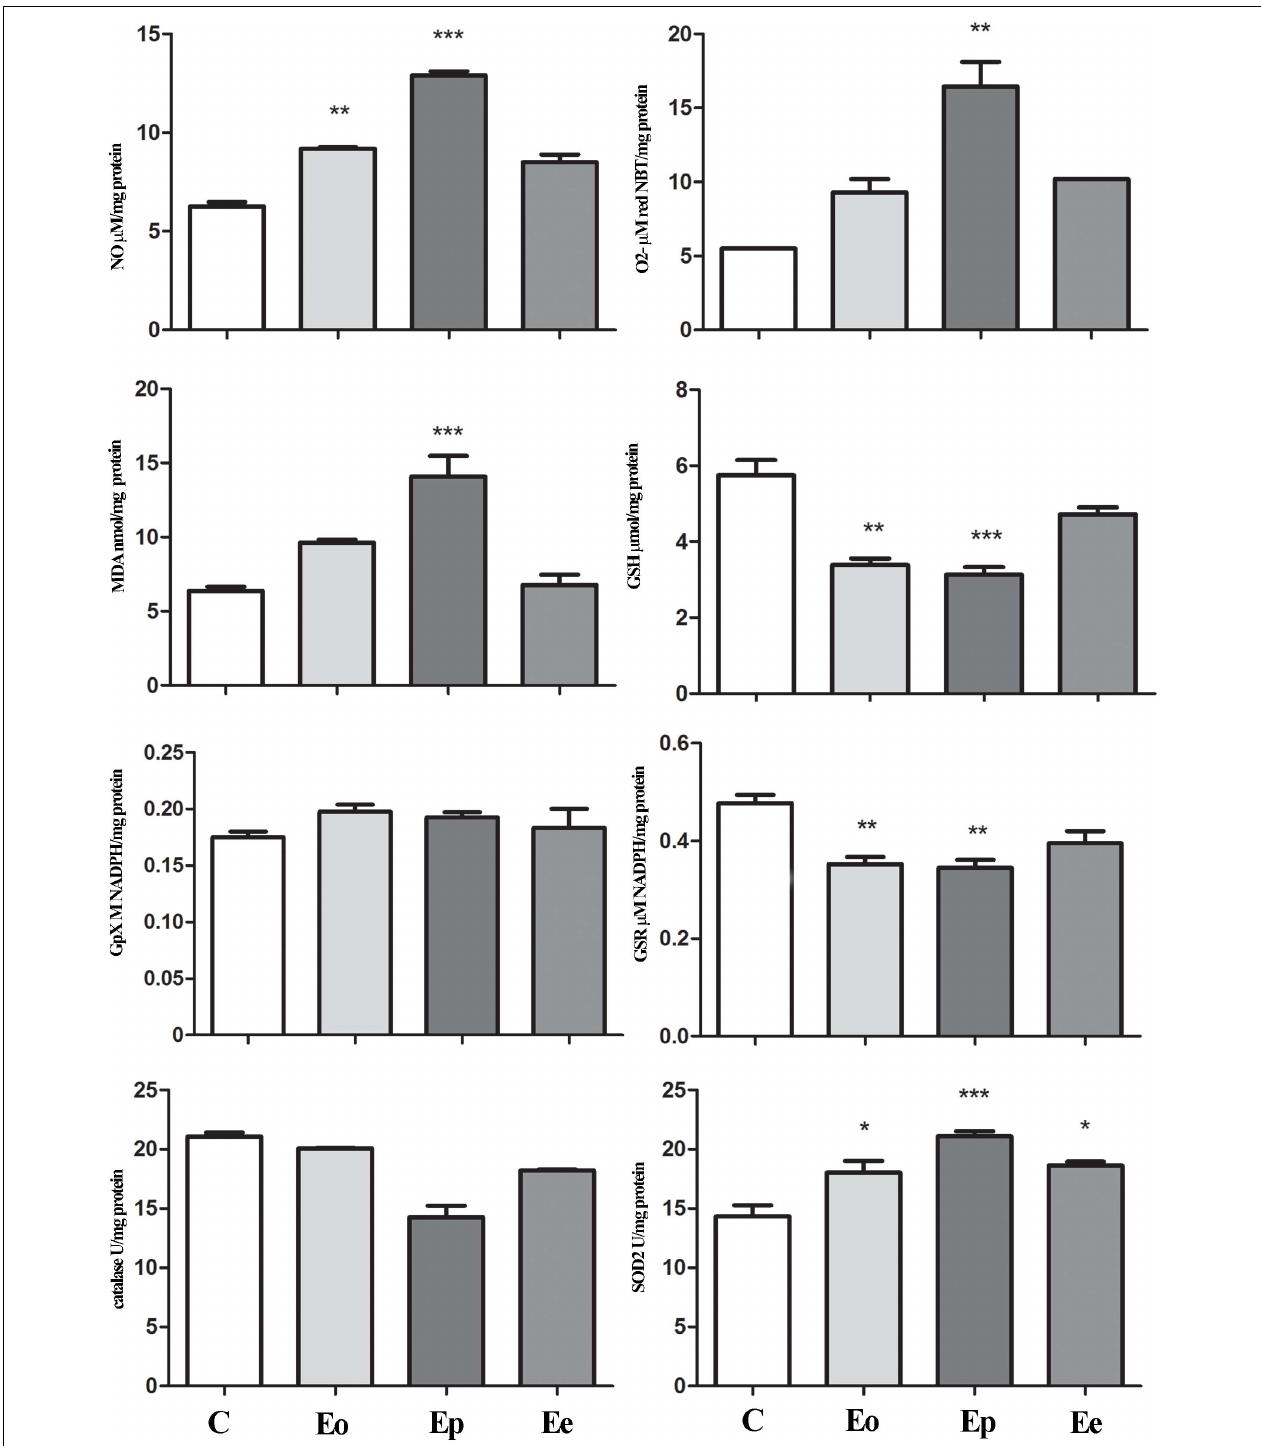
FIGURE 5 | Nitrosative/oxidative status assessment in the pituitary gland during EAE. Total nitrites (NOx; µ mol/mg protein) were determined to assess nitrosative status. For oxidative status assessment, O 2 − ( µ mol/min/mg protein), GSH ( µ mol/mg protein), and MDA (nmol/mg protein) levels and enzymatic activities of GPx (M NADPH/mg protein), GSR ( µ mol NADPH/mg protein), catalase (U/mg protein), and SOD2 (U/mg protein) were determined in the pituitary gland at the onset (Eo), peak (Ep), and end (Ee) of EAE rats. Values are presented as means ± SEM. * p < 0.05, ** p < 0.01, *** p < 0.001 statistically significant difference compared with the control (C)